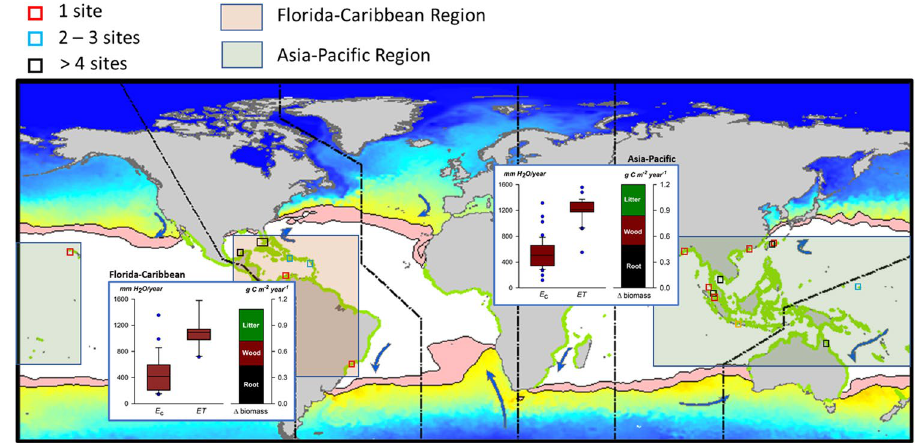
Figure 2. Location of 71 mangrove study sites from the Florida-Caribbean and Indo-Pacific regions from which net primary productivity (NPP, kg C m -2 year −1 ) data were used to determine canopy transpiration ( E c ). Polygons (pink) over the oceans represent 20 °C summer and winter isotherms influencing mangrove distributions (updated from Duke et al. 1998, Glob. Ecol. Biogeogr. Letts. , v. 7, p. 27–47). Insets represent comparative average E c , ET , and NPP values for litter, wood, and roots assuming a continuous mangrove coverage versus ET at a scale of 1 km 2 for each of the two regions. Box plot depictions are the same as in Fig. 1.